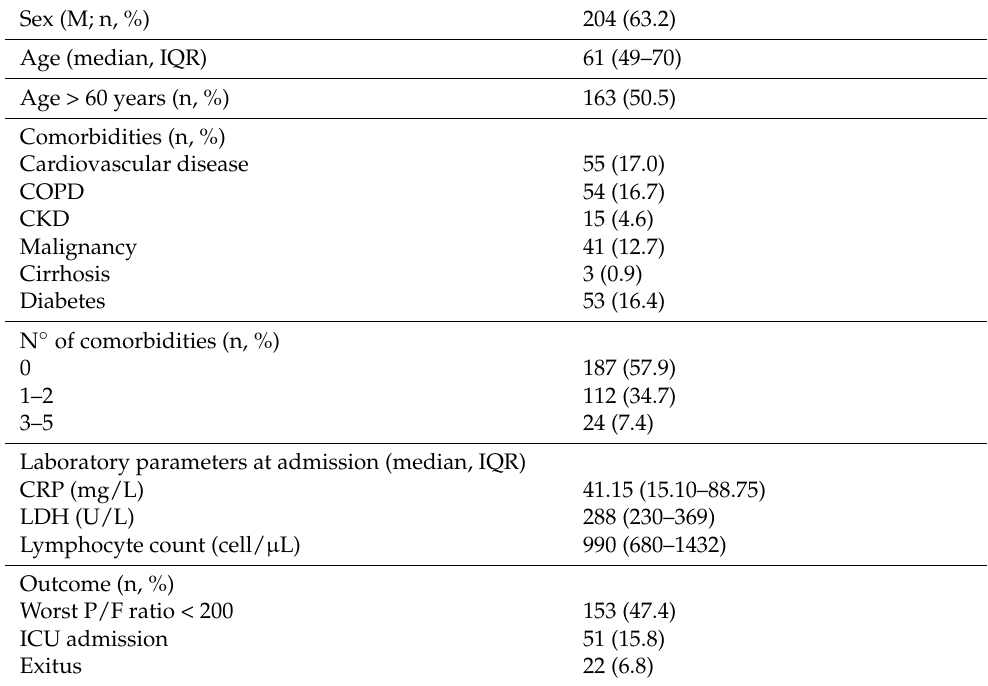
Table 1. Demographic and clinical characteristics of patients hospitalized for COVID-19 and included in the study (N =